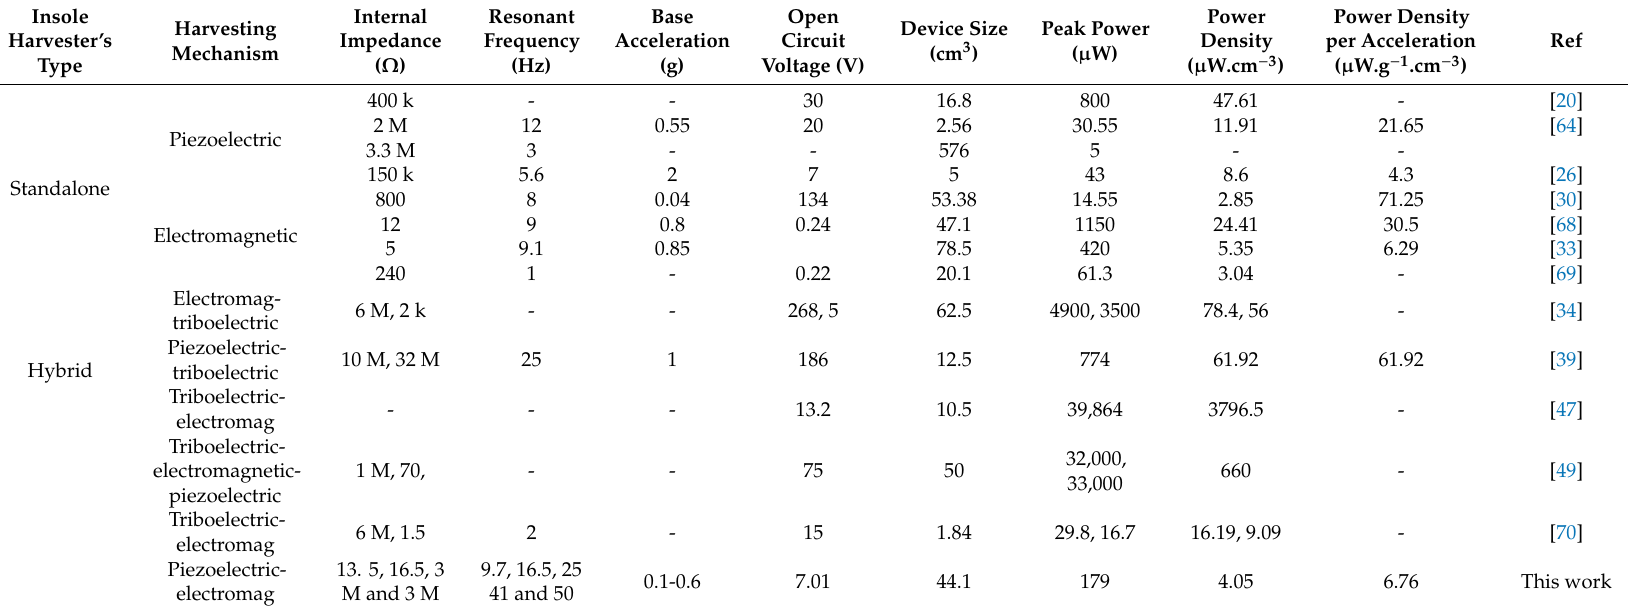
Table 4. Literature summary of piezoelectric, electromagnetic, triboelectric and hybrid insole energy